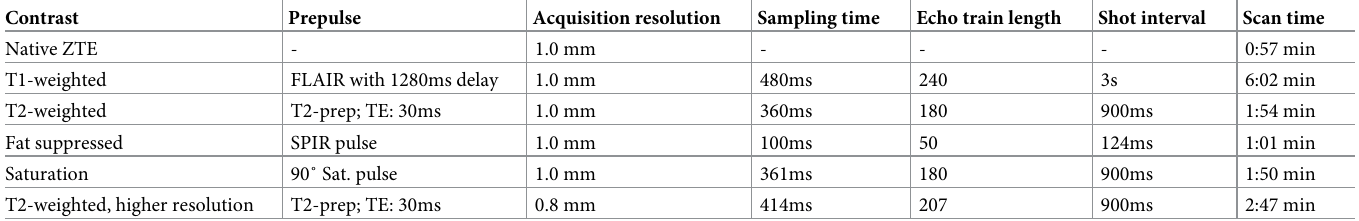
Table 1. ZTE imaging